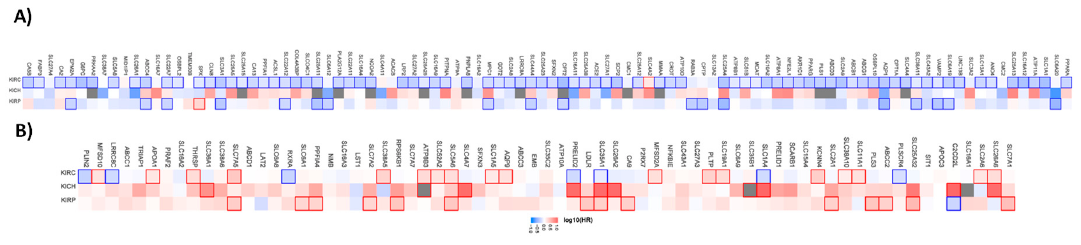
Figure 2. Hazard ratio of the organic anion transporter expression in di ff erent renal cancer subtypes. The hazard ratio (HR) was calculated for ( A ) the favorable and ( B ) unfavorable list of genes separately for renal clear cell carcinoma (KIRC), renal papillary cell carcinoma (KIRP), and chromophobe renal cell carcinoma (KICH). The red and blue colors denote higher and lower risk, respectively. The rectangle with frames represents the statistically significant HR ( p < 0.05).